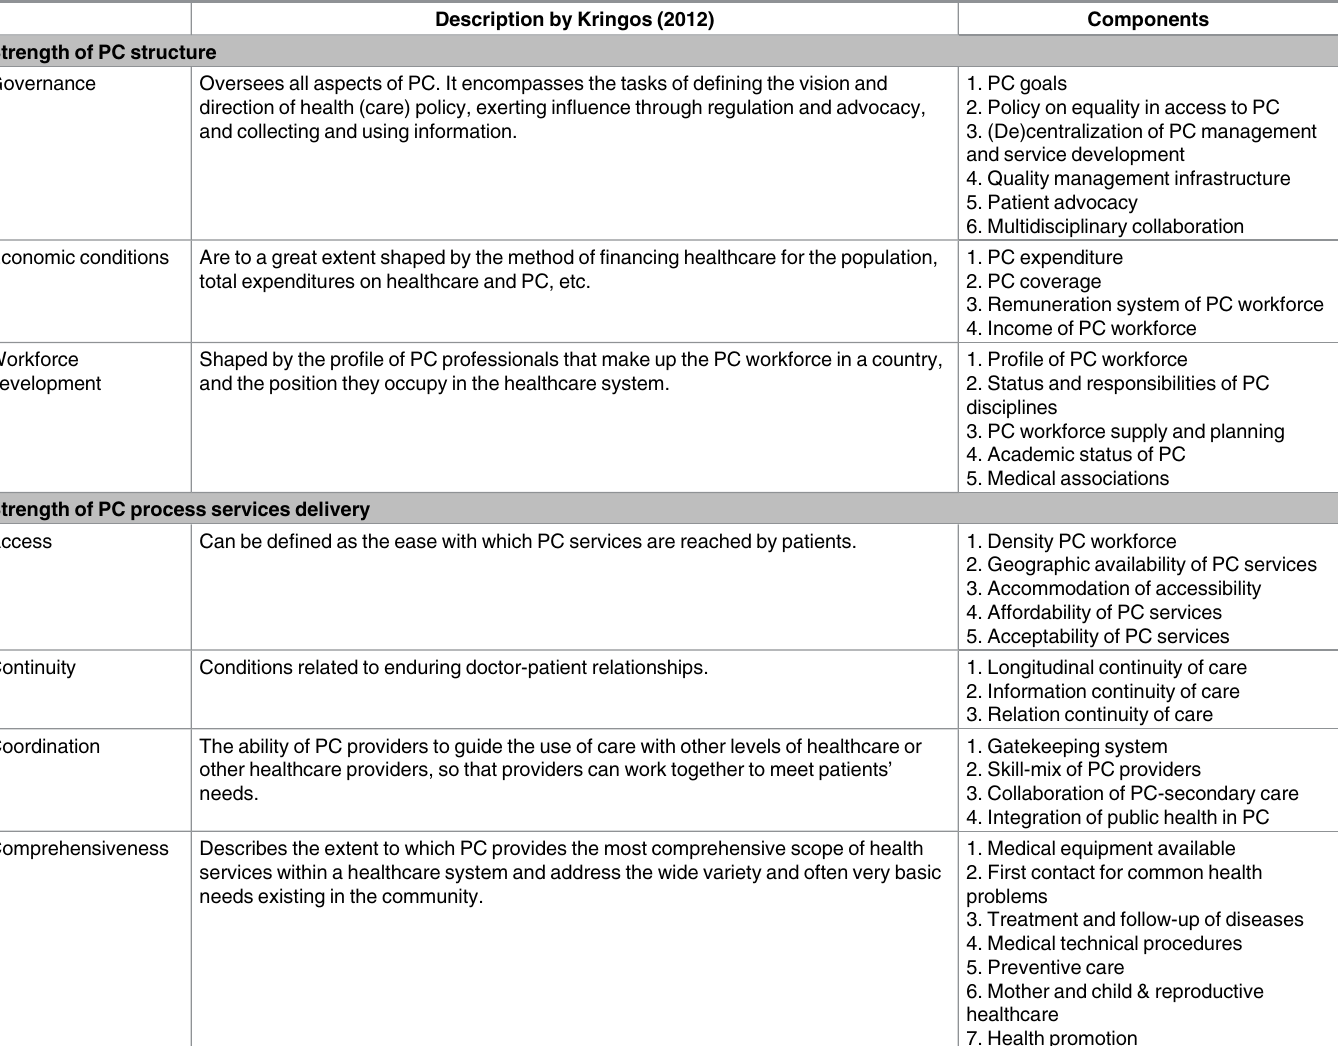
Table 1. Framework of the European Primary Care